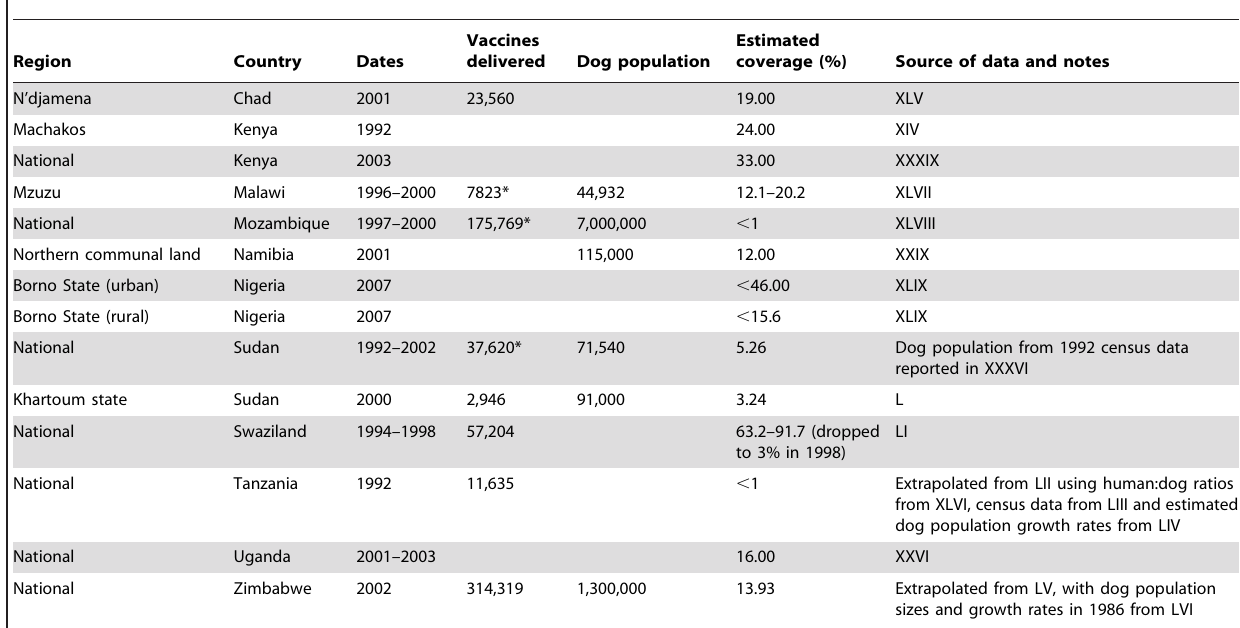
Table 2. Reported and estimated vaccination coverages in domestic dog populations from various settings in sub-Saharan Africa since 1990.